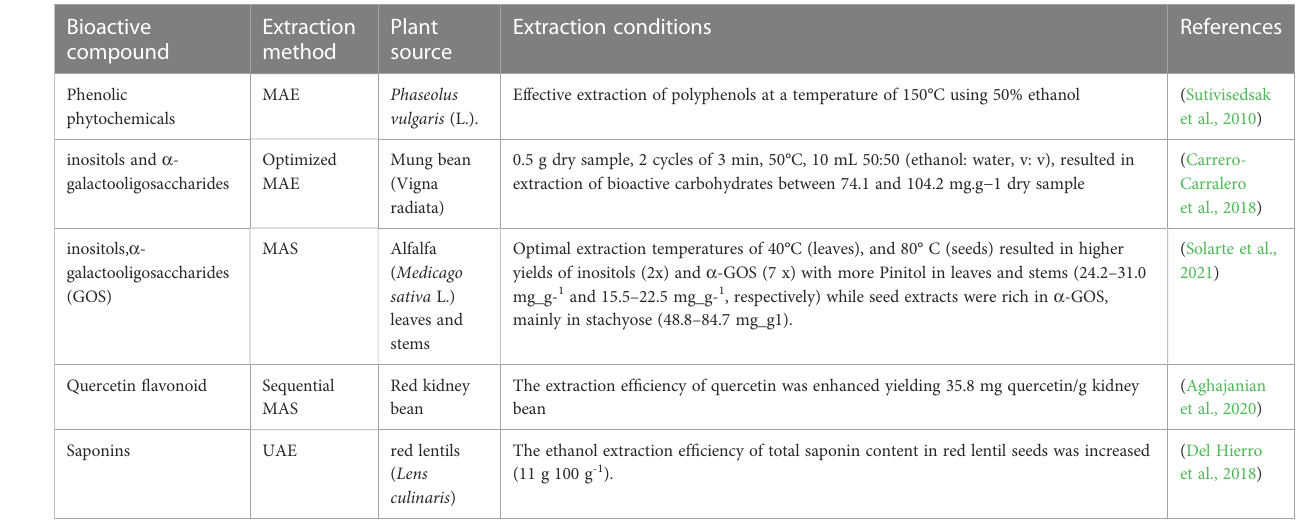
TABLE 6 Bioactives from legumes and their extraction